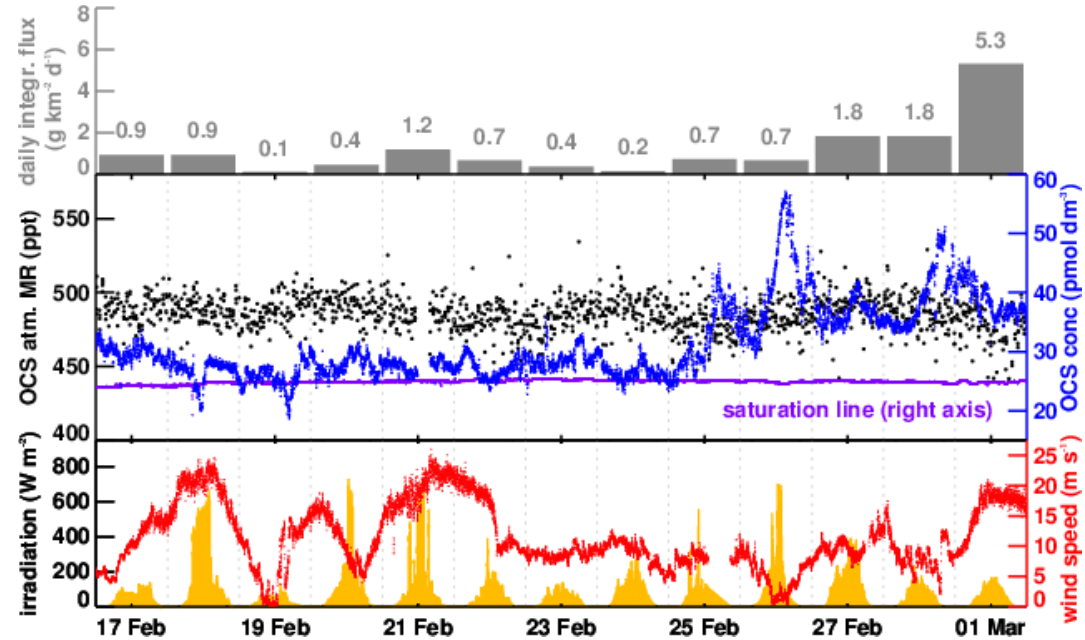
Figure 24. Time series of OCS atmospheric mixing ratios (black) and dissolved concentrations (blue) measured by MICA between 16 Febru- ary and 1 March; data for other times are available but with significant interruptions (for more details, see text). Also shown are approximate saturation thresholds calculated from mixing ratios and seawater temperature (purple) in the same panel. The top panel shows the daily integrated sea–air OCS fluxes in gkm − 2 d − 1 , while the bottom panel shows the wind speed (red) and irradiation